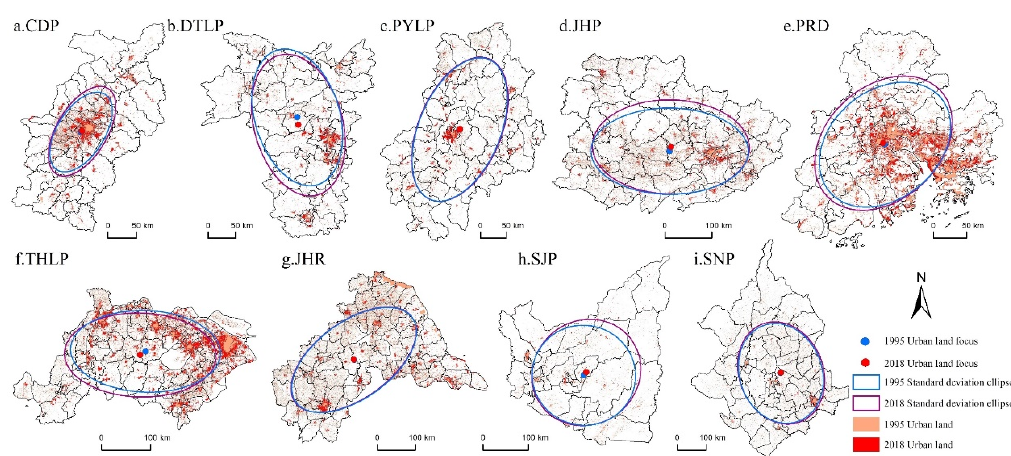
Figure 5. Standard deviation ellipses of urban land, 1995–2018. Table 3. Variation in the standard deviation ellipse for cropland and urban